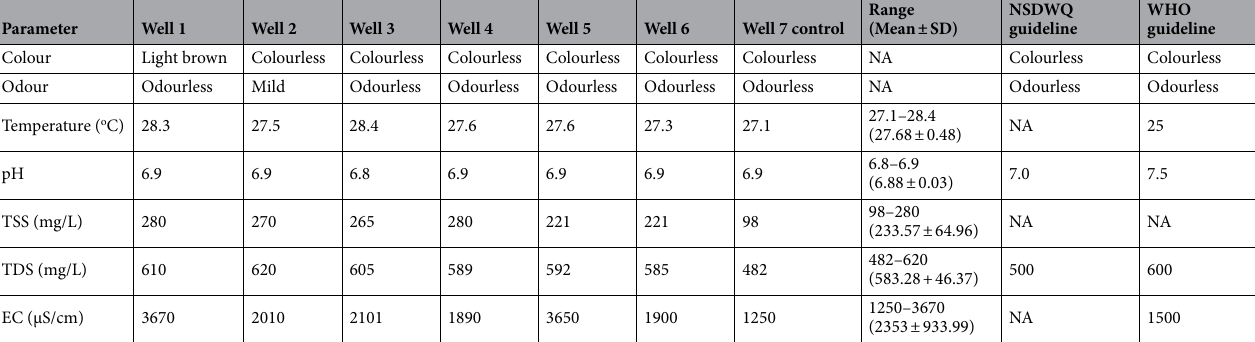
Table 2. Result of physico-chemical analysis of the well water samples. SD = Standard Deviation, NA = Not Available, TSS = Total Suspended Solid, TDS = Total Dissolved Solid, EC = Electrical Conductivity, NSDWQ = Nigerian Standard for Drinking Water Quality and WHO = World Health Organization.